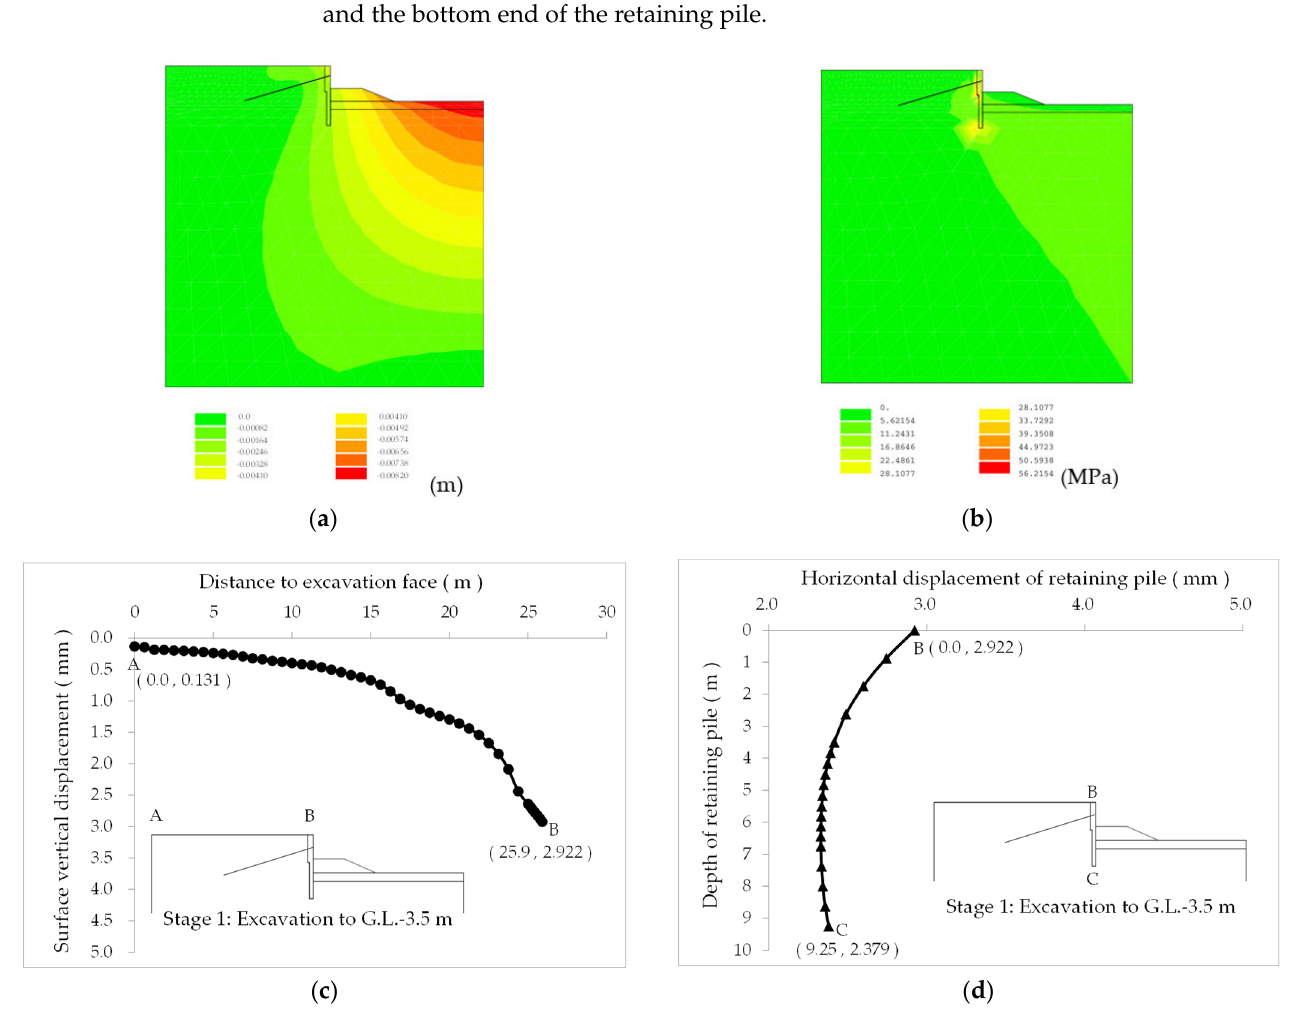
Figure 8. Results obtained with the 2D FEM analysis of the first ‐ stage excavation: ( a ) iso ‐ value of the total displacement; ( b ) iso ‐ value of the second deviatoric stress; ( c ) vertical surface displacement along the AB line; ( d ) horizontal displacement of the retaining pile along the BC line.